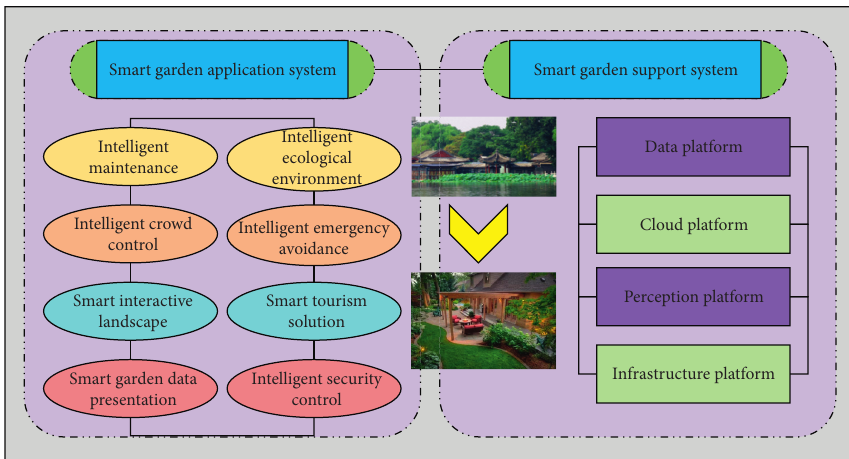
Figure 2: Hierarchy diagram of smart garden construction